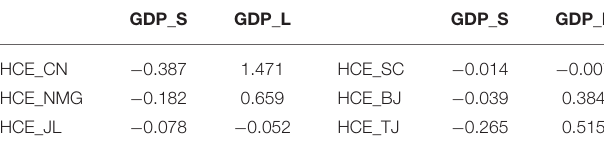
TABLE 5 | Robustness test results: change in the sampling